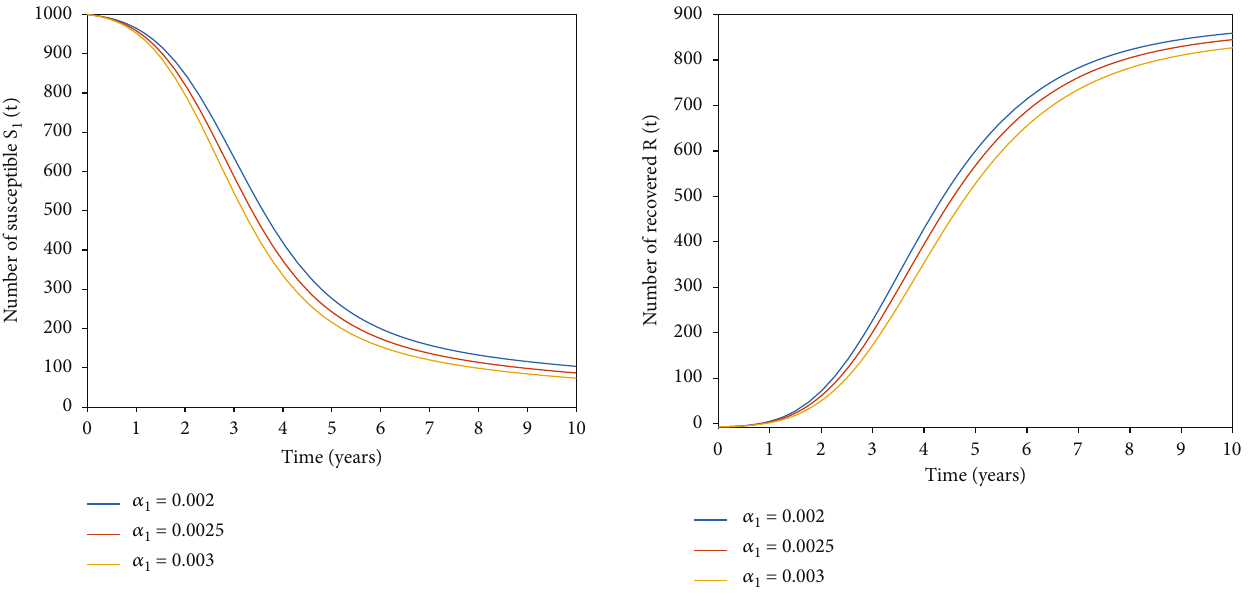
Figure 16: Transformation of recovered individuals for varied infection rate α 1 .